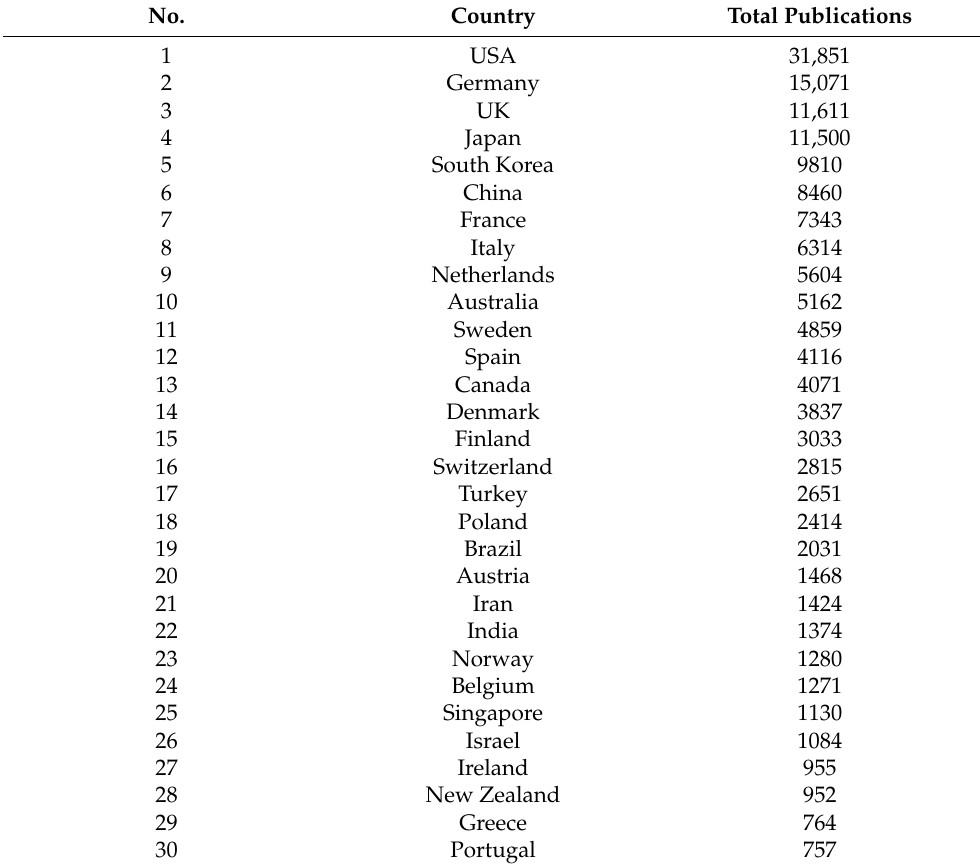
Table 2. The total number of publications from the top 30 countries during the period 1990–2020. No.